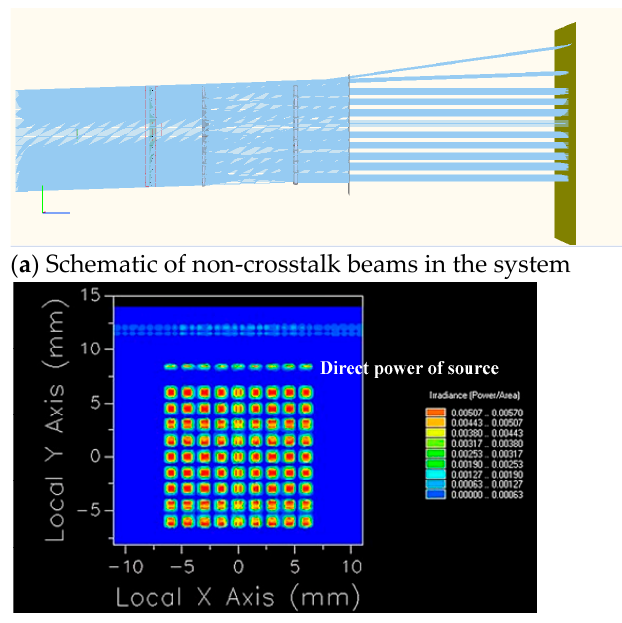
Figure 14. Imaging diagram with a crosstalk suppression stop array (Y axis, δ = − 2°).